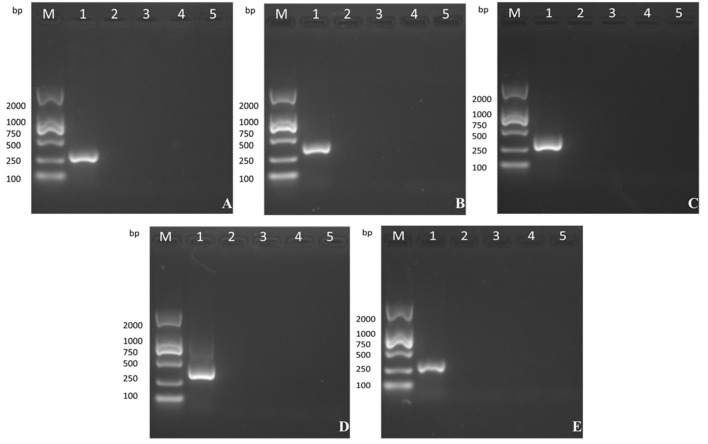
Evaluation of the genetic stability of the recombinant virus in BHK-21 cells after 5, 10, 15, and 20 passages. (A) TC7L-TK2L gene of MVTTEAB (lanes 2–5), (B) TE3L gene of MVTTEAB (lanes 2–5), (C) TA35L gene of MVTTEAB (lane 2–5), (D) TB13R gene of MVTTEAB (lanes 2–5), and (E) TA66R gene of MVTTEAB (lanes 2–5). PCR of all gene-deleted mutants produced negative results, compared to the corresponding positive PCR controls (lane 1).